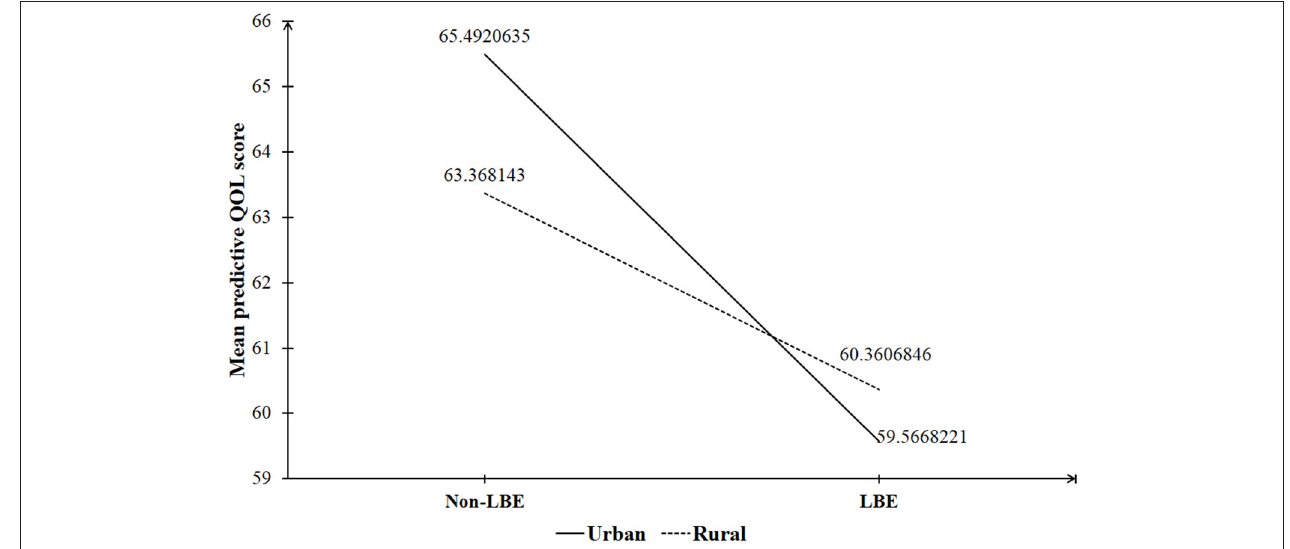
FIGURE 1 | The interactive effect of childhood left-behind experience (LBE) and place of origin on quality of life (QOL) of Chinese University